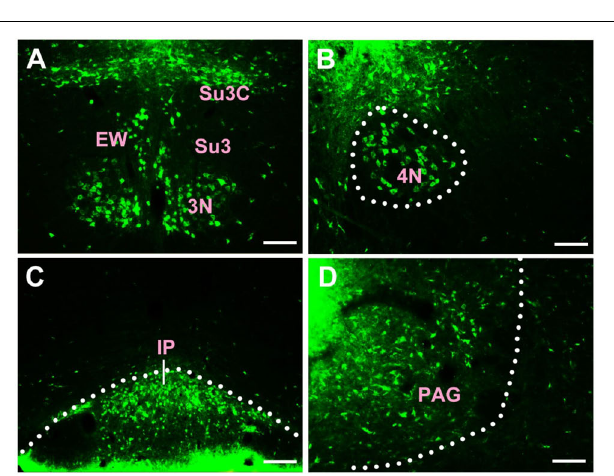
FIGURE 4 | The distribution of neurons labeled by CB in the midbrain Part II (A–D) . EW, Edinger-Westphal nucleus; Su3, supraoculomotor periaqueductal gray; Su3C, supraoculomotor cap; 3N, oculomotor nucleus; 4N, trochlear nucleus; IP, interpeduncular nucleus; PAG, periaqueductal gray. Scale bar = 100 µ m.